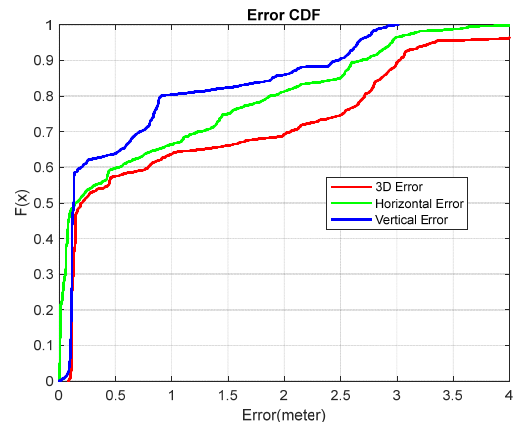
Figure 8. The trajectories from different integration results